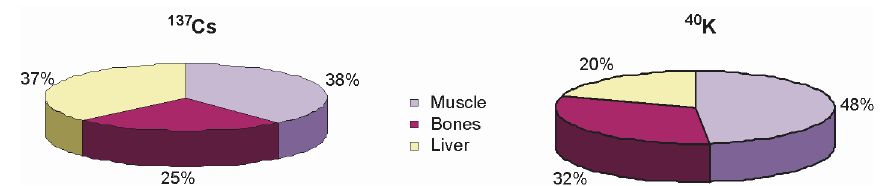
137 40 Cs and K in different tissues and organs of the red fox ( Vulpes vulpes )